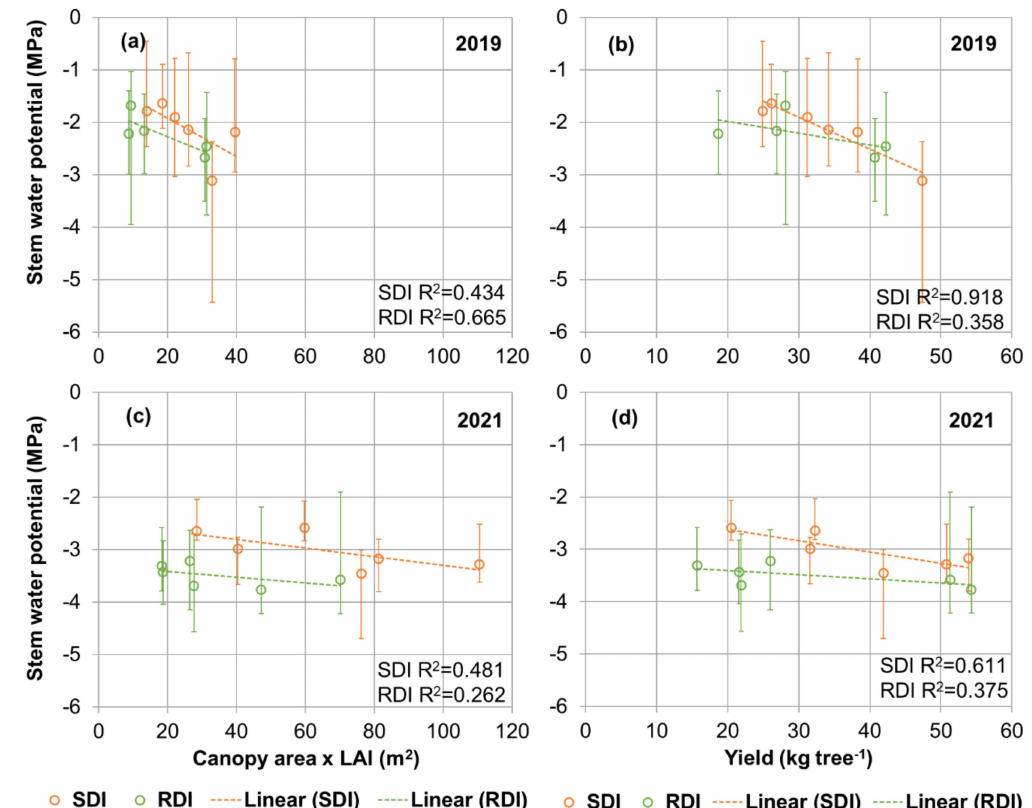
Figure 6. Median stem water potential of Periods 2 and 3 for soil moisture-monitored trees in sustained (SDI) and regulated (RDI) deficit irrigation treatments in relation to canopy leaf area ( a , c ) and yield ( b , d ) for 2019 and 2021. Error bars show the minimum and maximum stem water potential. R 2 is the coefficient of